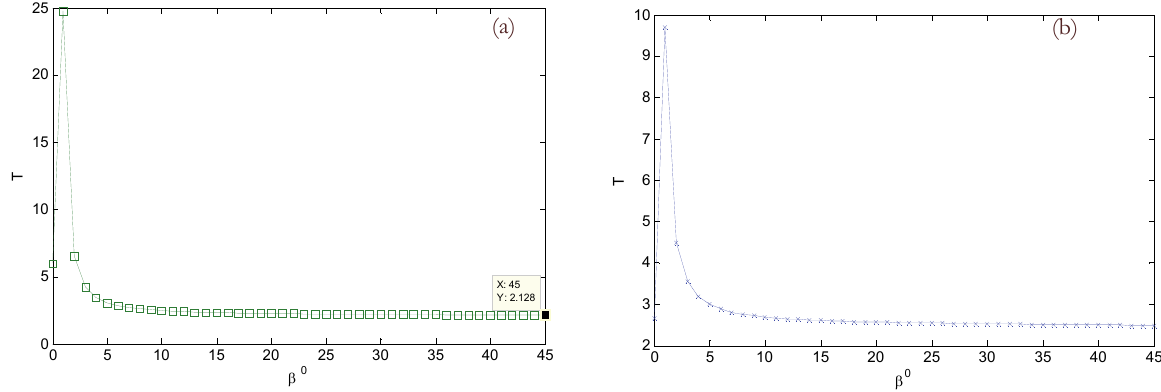
Figure 2: Relationship between the scatter T and the angle  for: (a) 10 HNAP steel [10]; (b) PA4 aluminum alloy [11]. Scatters are computed only for experimental tests under combined bending and torsion. The angle  corresponding to the minimum scatter value is registered for each examined material and listed in Table